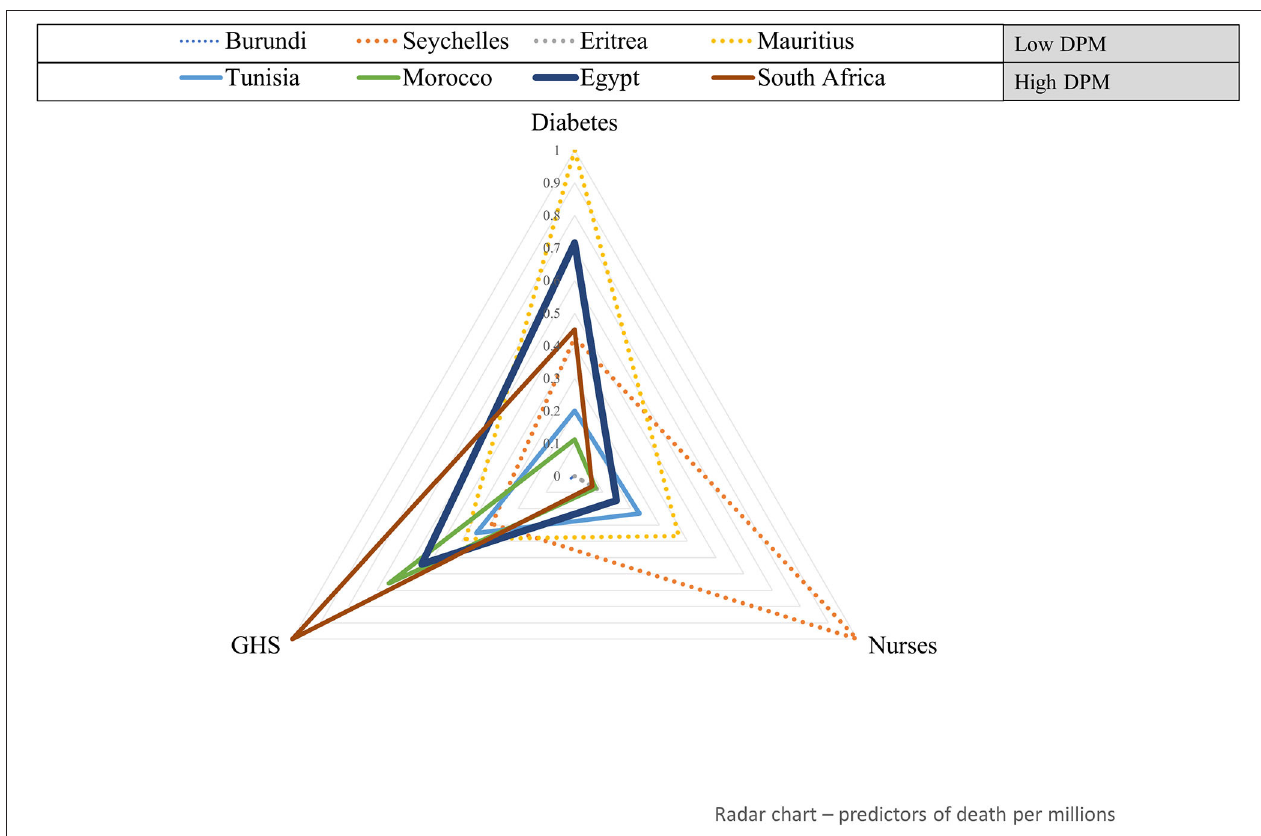
FIGURE 2 | Health system and clinical factors’ profile of eight African countries with a wide range of COVID-19 deaths per 1 million populations. Standardized values of variables significantly associated with COVID-19 deaths per 1 million populations (GHS index and diabetes) are plotted for eight countries having the lowest (upper-left) to highest (lower-right) COVID-19 DPM. DPM, Deaths per one million